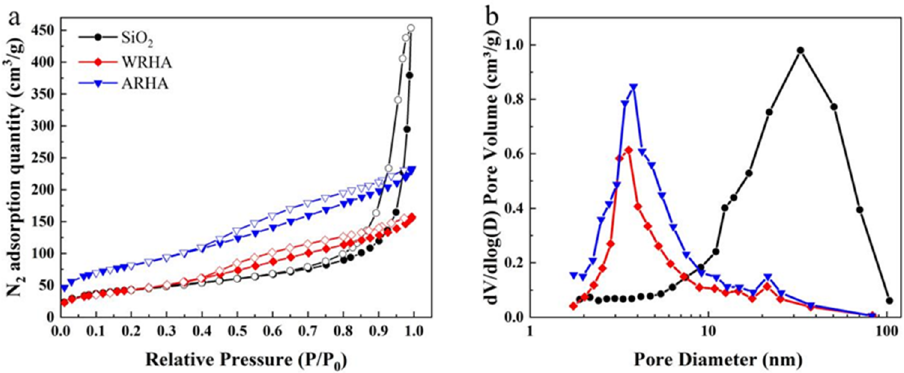
Figure 3. ( a ) N 2 adsorption–desorption isotherms and ( b ) pore size distributions of the three fillers samples. Table 3. The surface area, pore volume, and average pore diameter of the three fillers. Samples